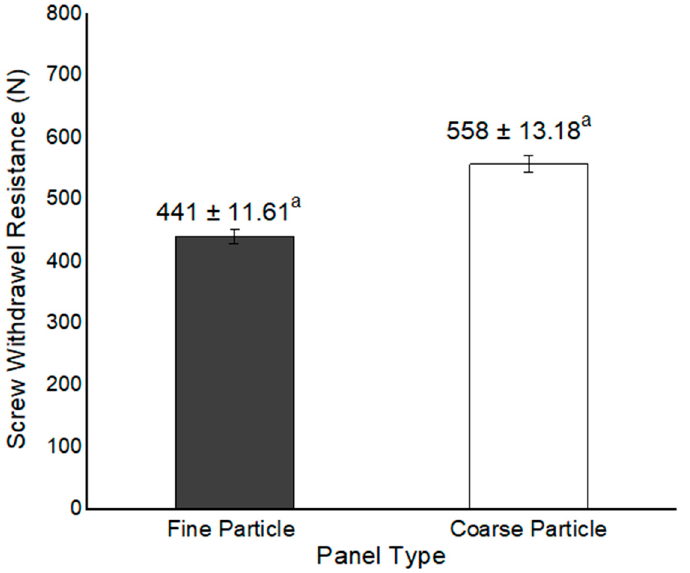
Figure 4. Screw withdrawal resistance of the sample. Values followed by the same letters are sta- tistically not different at p < 0.05.